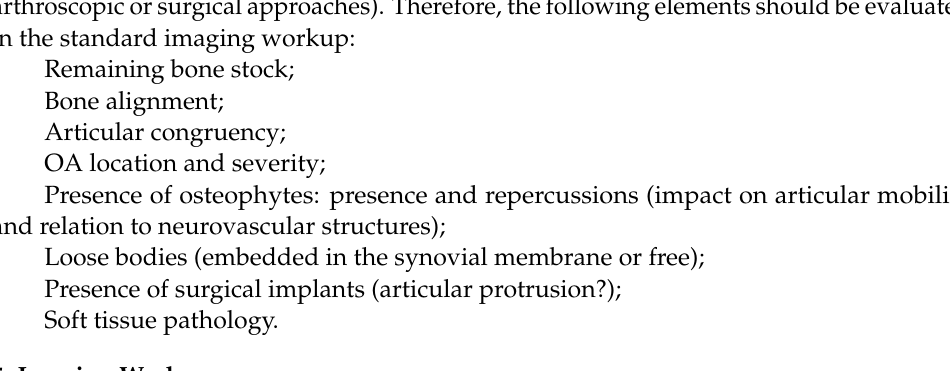
Figure 6. Olecranon fossa osteophytic filling. Osteophytic filling (white arrow) of the olecranon fossa (white dotted line) is shown on ( a ) a profile radiograph and ( b ) a sagittal CT-scan in a 26-year-old man who suffered from a humeral fracture and presents extension dysfunction when its corresponding normal aspect is shown in ( e , f ). The filling is also seen on ( c ) an extension global illumination 3D reformat and ( d ) in flexion (white arrows), when the normal aspect is shown in ( g , h ) (dotted white star).